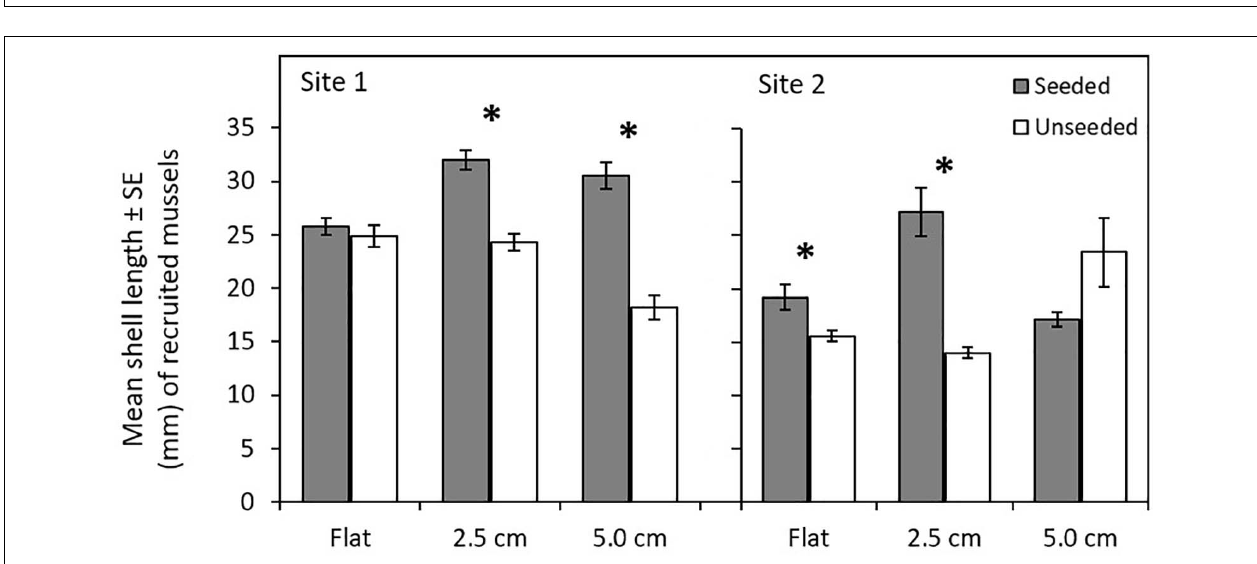
FIGURE 1 | Non-metric multi-dimensional scaling (nMDS) ordination on Bray–Curtis resemblances using fourth root transformed multivariate data showing the effects of mussel seeding (using Mytilus spp.) on community composition at two sites in Plymouth, United Kingdom (NE Atlantic). Community composition data were collected from seeded (denoted by dark squares) and unseeded (gray circles) tiles at the end of the 15-month experiment (April 2017–July 2018).